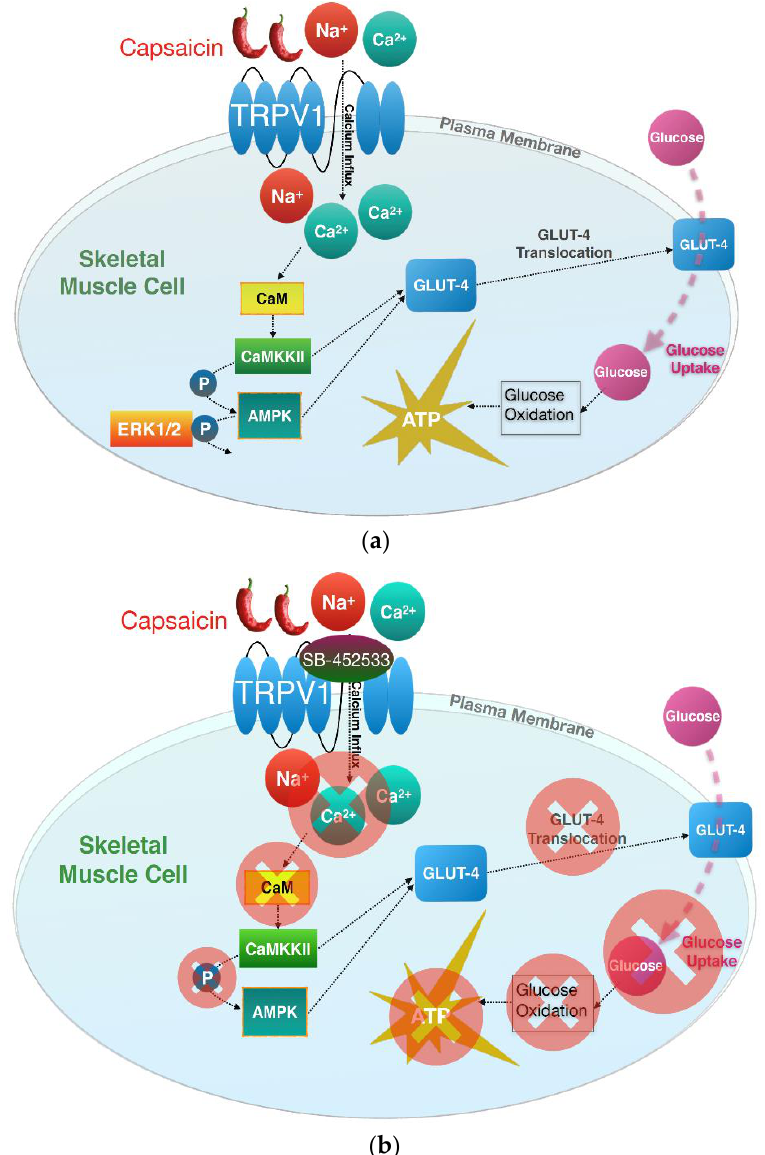
Figure 8. Graphical summary of capsaicin-induced signal transduction in mouse skeletal muscle cells . ( a ) Activation of CAMKK2 and AMPK, dephosphorylation of ERK1/2, glucose oxidation, and ATP production by capsaicin in skeletal muscle cells. ( b ) Pharmacological blocking of TRPV1 and subsequent inhibition of downstream signalling events, glucose oxidation, and ATP production in skeletal muscle cells.